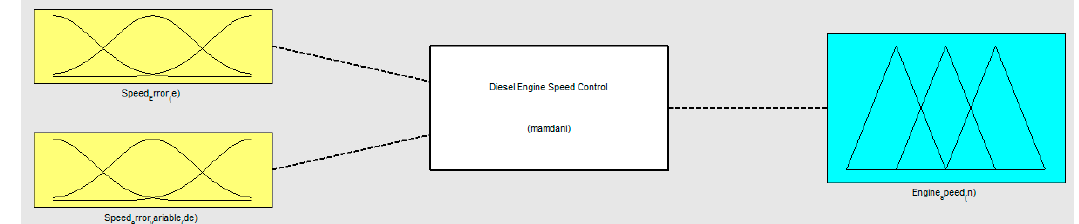
Figure 6. Fuzzy logic control inference.